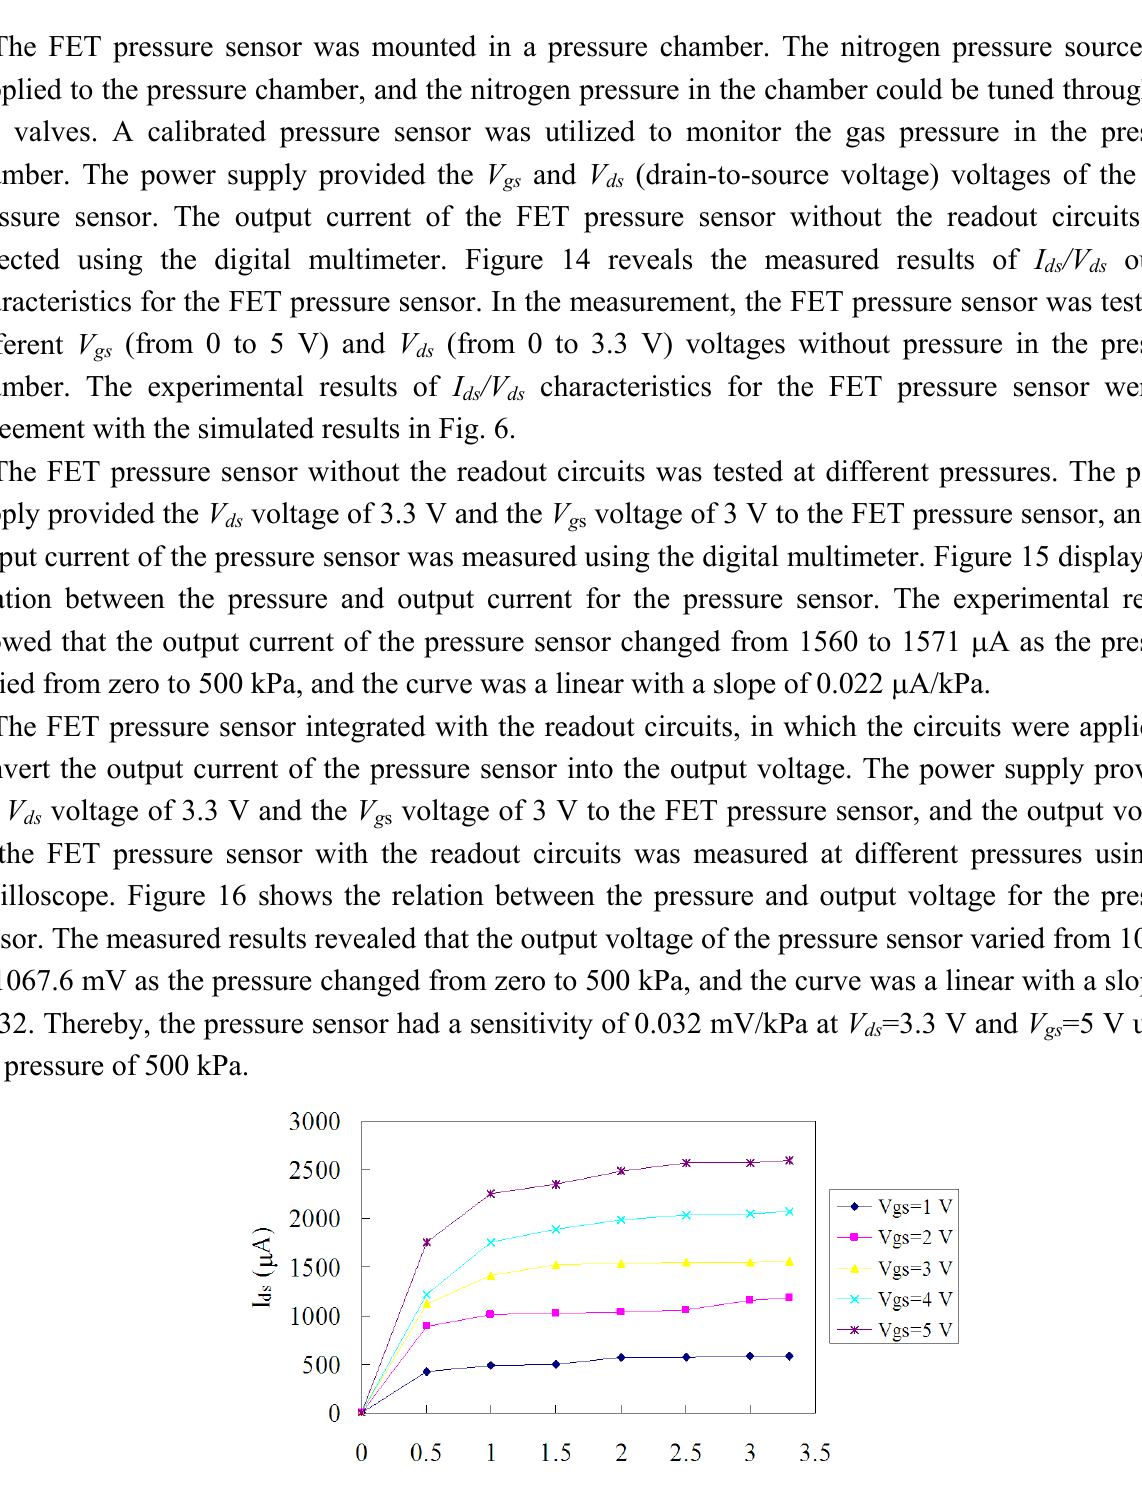
Figure 14. Measurement of I